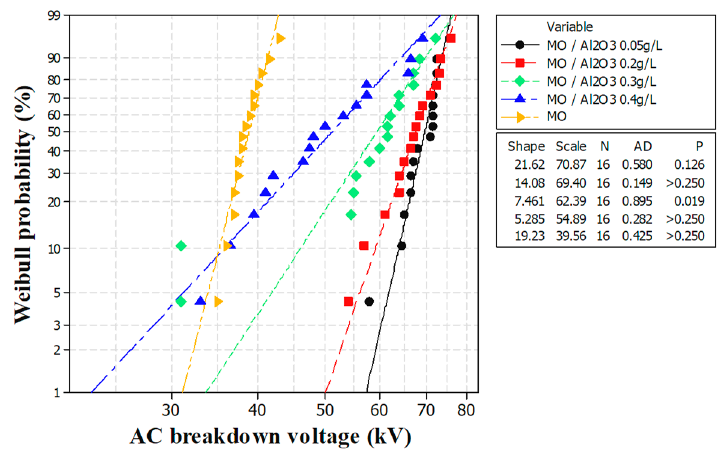
Figure 5. Weibull probability of the average reading of the breakdown voltage of MO/Al 2 O 3 (13 nm) NFs.